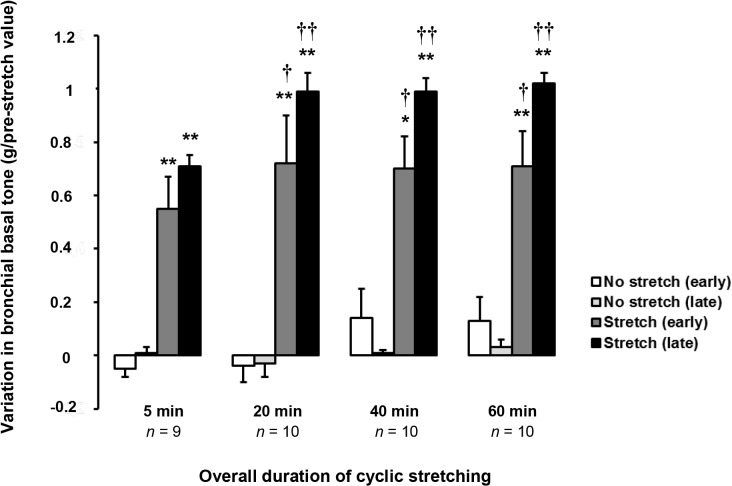
Effect of the duration of cyclic stretching on airway basal tone.The pre-stretching basal tone was recorded immediately before the onset of cyclic stretching (Fig 2). The variation in basal tone corresponds to the deviation from the pre-stretching value. The early stretching-induced effect corresponds to the change in bronchial basal tone at the start of the cyclic stretching (Fig 2). The late post-stretching effect corresponds to the spontaneous increase in basal tone after the cessation of cyclic stretching (until basal tone reaches a plateau after 10 min (Fig 2). Data are quoted as the mean ± SEM. *P <.05, **P <.01 vs. paired non-stretched control; †
P <.05, ††
P <.01 vs. 5 min of cyclic stretching. See Table 3 for details.